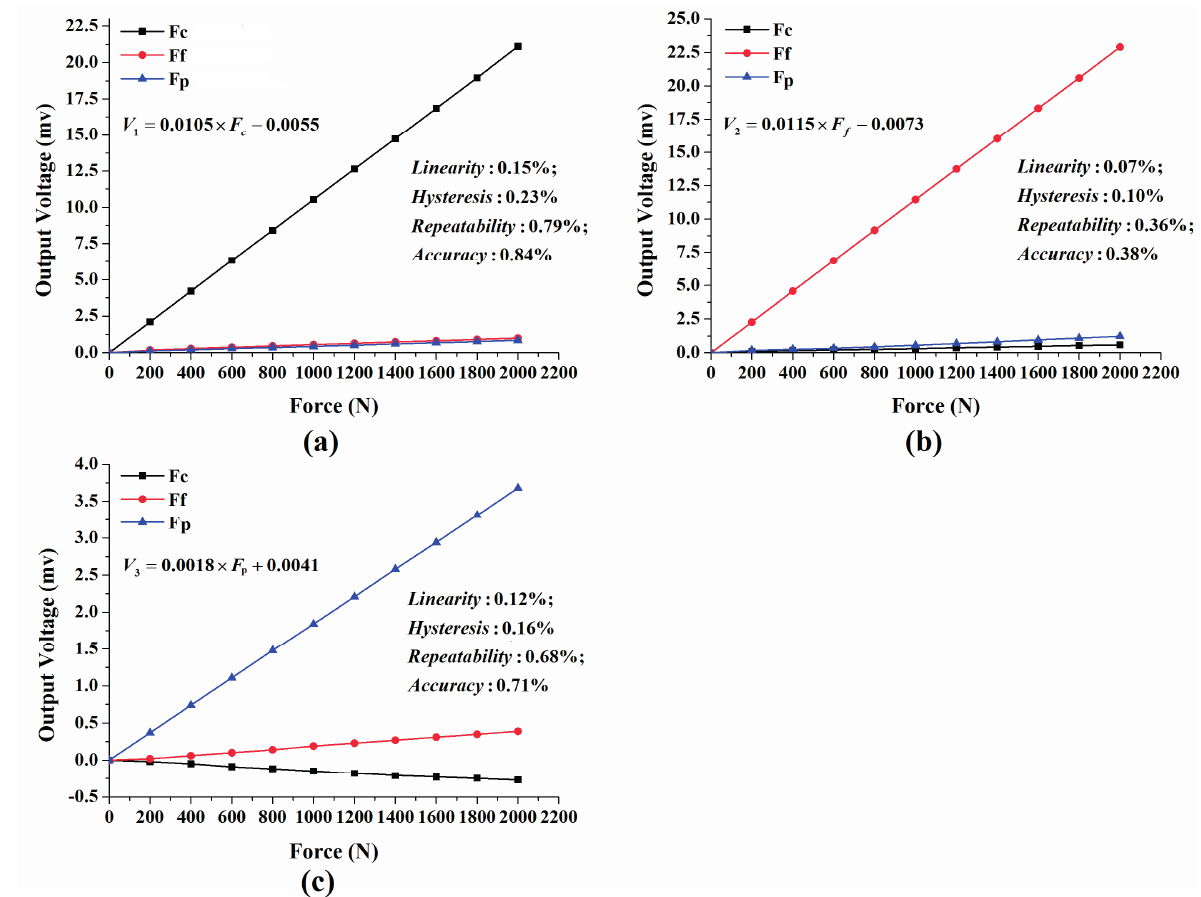
Figure 8. Calibration curve and cross-interference for: ( a ) main cutting force F c ; ( b ) feed force F f ; ( c ) thrust force F p